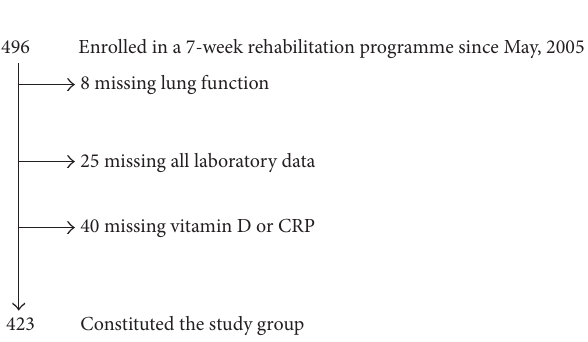
Figure 1: Flow chart of patients included in the study.